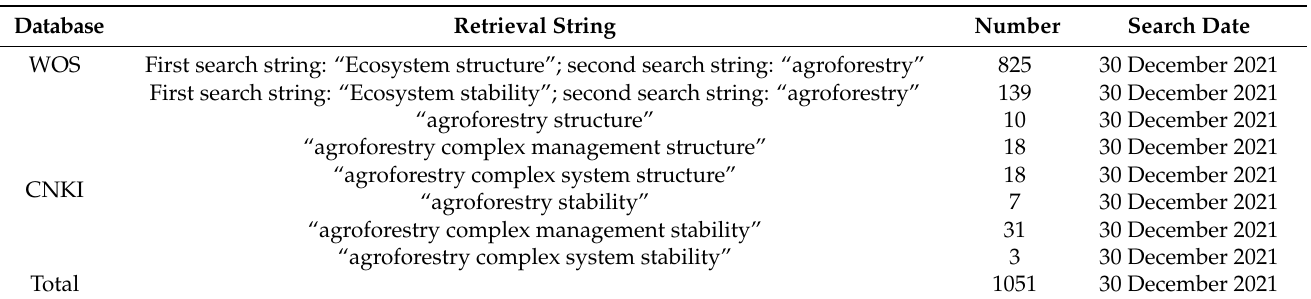
Table 1. Literature search